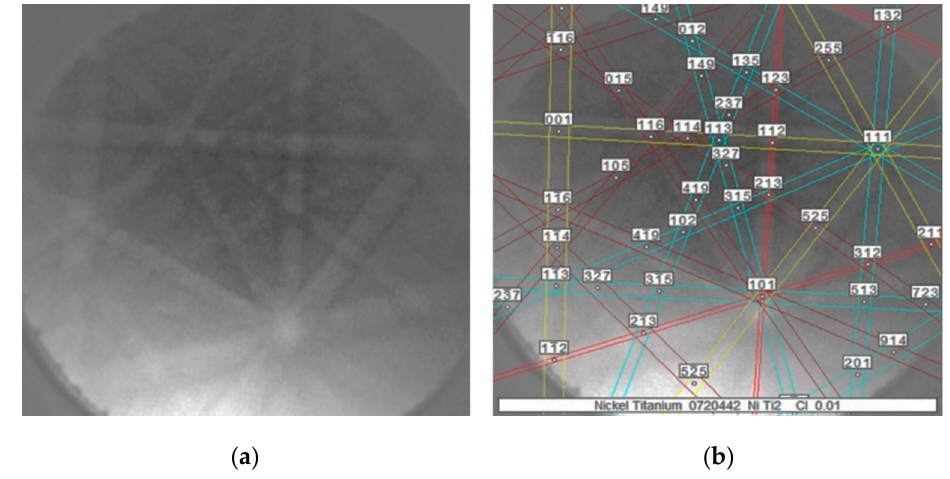
Figure 9. Kikuchi patterns of the point 2 indicated on Figure 8a indexed as Ti 2 Ni phase ( a ) Kikuchi pattern and ( b ) indexation of the pattern presented in ( a ).